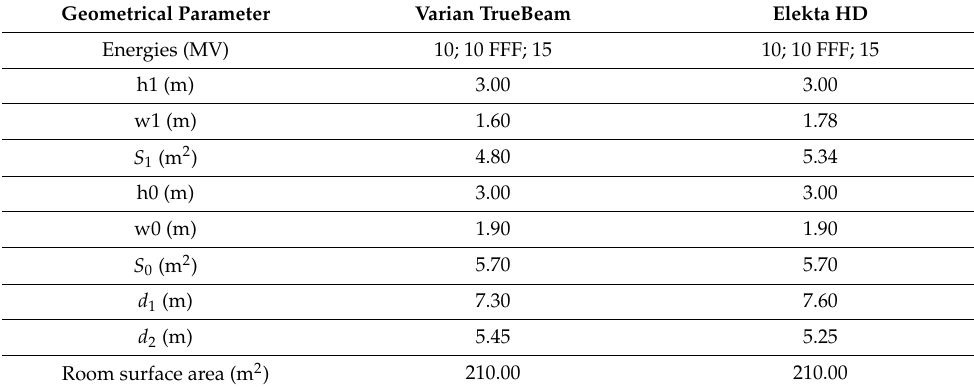
Table 1. The data and the geometrical information of the two linac